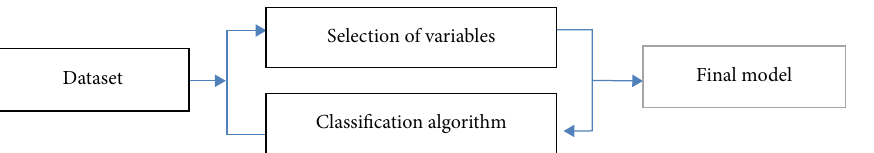
Figure 2: Data selection by the wrapper and embedded